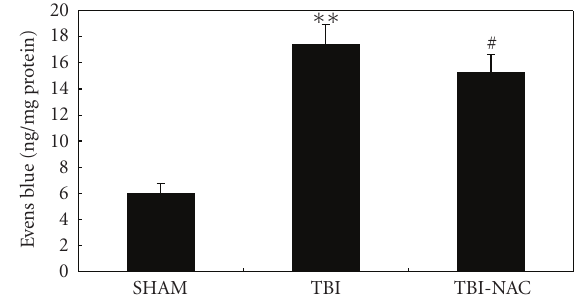
77 . Figure 5: Alterations in brain water content in SHAM group ( n = 5), TBI group ( n = 6), and TBI-NAC group ( n = 6). The brain water content of the injured side was increased significantly at 3 days after TBI. NAC treatment markedly reduced brain water content. No di ff erence of brain water content was detected in the uninjured side among the three groups. ∗∗ P < . 01 versus SHAM group; ## P < . 01 versus TBI group.